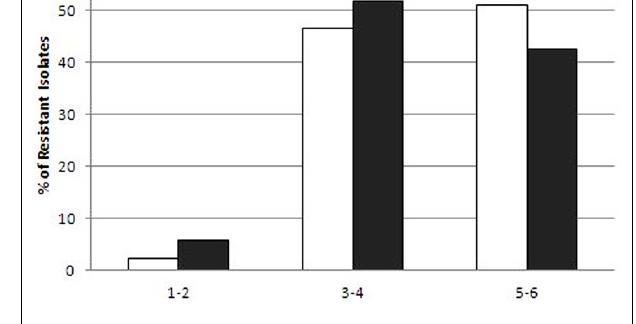
FIGURE 3 | Level of multi-resistance in intermediate ciprofloxacin- resistant isolates from sludge (white bars) and raw sewage (gray bars). The x -axis shows the abundance of the strains resistant to 1–2, 3–4, and 5–6 additional antibiotic compounds.